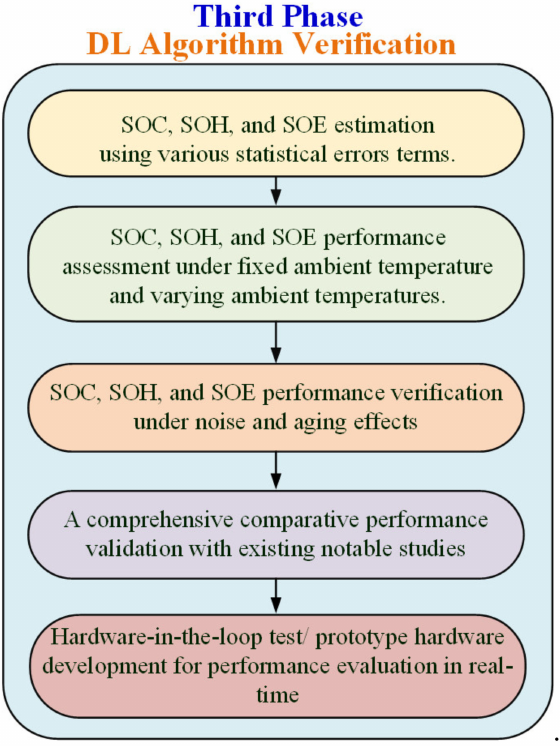
Figure 4. The performance validation procedures for DL-based SOX